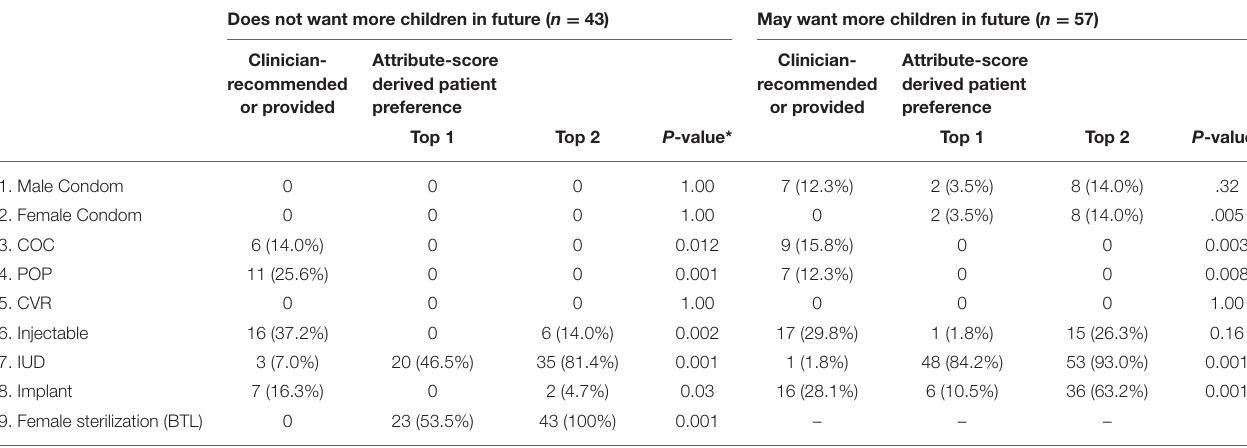
TABLE 3 | Clinician-recommended/provided contraceptive methods and patient contraceptive preferences derived from attribute-based scoring using a Contraceptive Preference Assessment Tool among women in Botswana, stratified by those who do or do not want more children in the